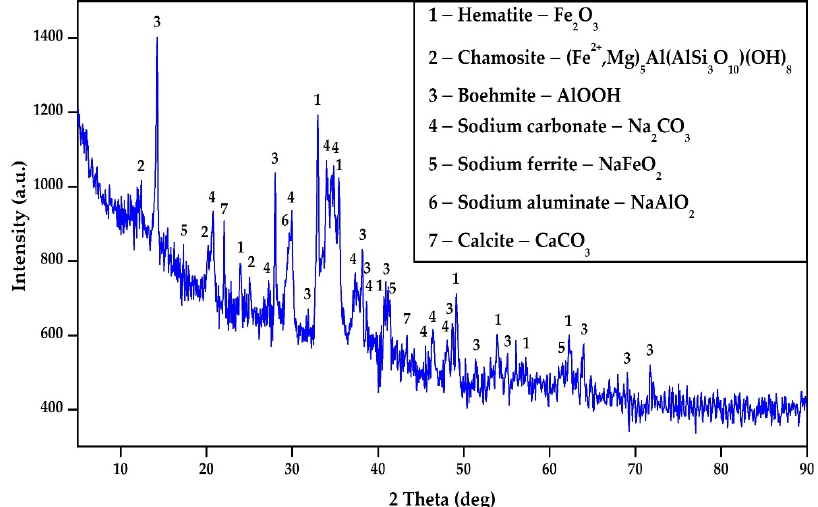
Figure 2. X-ray di ff raction analysis of the electrostatic precipitator dust of the RUSAL-Kamensk-Uralsky Figure 2. X-ray diffraction analysis of the electrostatic precipitator dust of the RUSAL-Kamensk- alumina refinery in Uralsky alumina refinery in Russia.